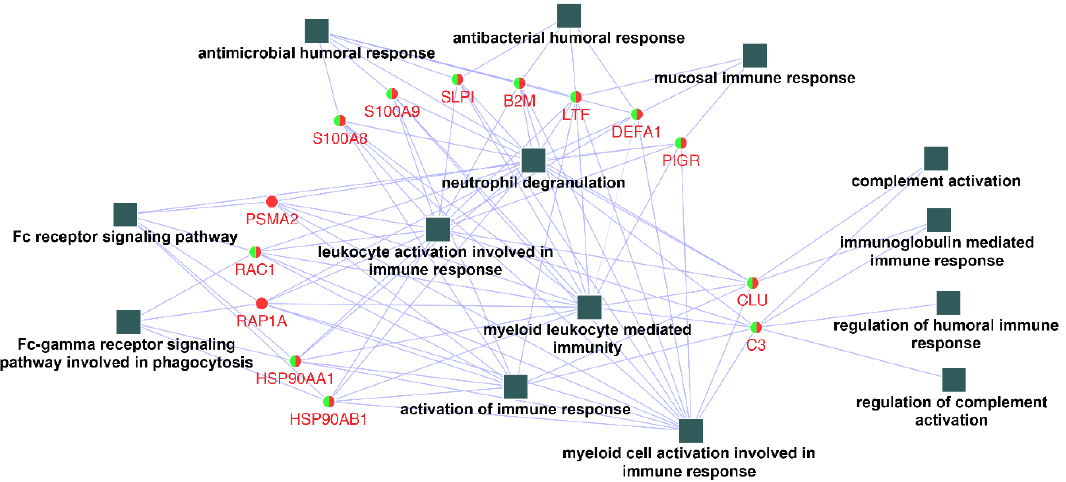
Figure 4. networks contracted by the 14 hub proteins selected and their related functional terms identified (squares, c.f. Figure 3). After connection degree analysis, a list of 14 proteins (degree ≥ 6) were selected and imported to Cytoscape to reconstruct the ontological network. All fourteen biological process terms (square) were found to be directly connected to the hub genes (circles).